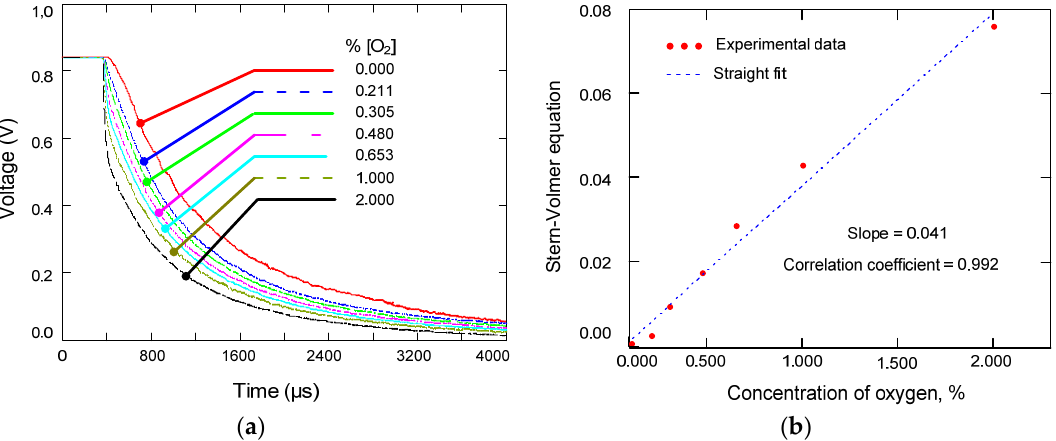
Figure 19. ( a ) Phosphorescent responses for different oxygen concentrations. ( b ) Calibration curves according to lifetime lengths.